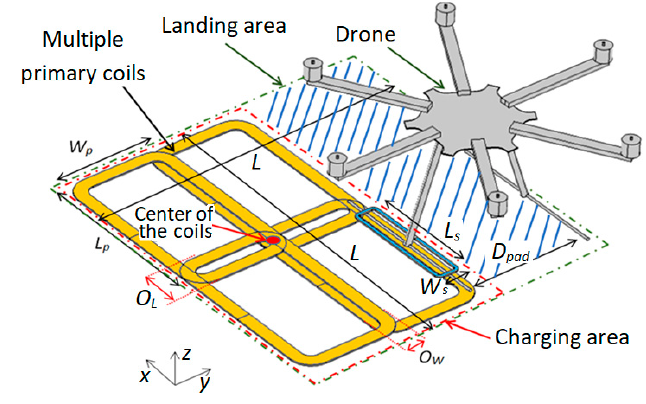
Figure 2. Configuration of the WPT charging coils for a drone.